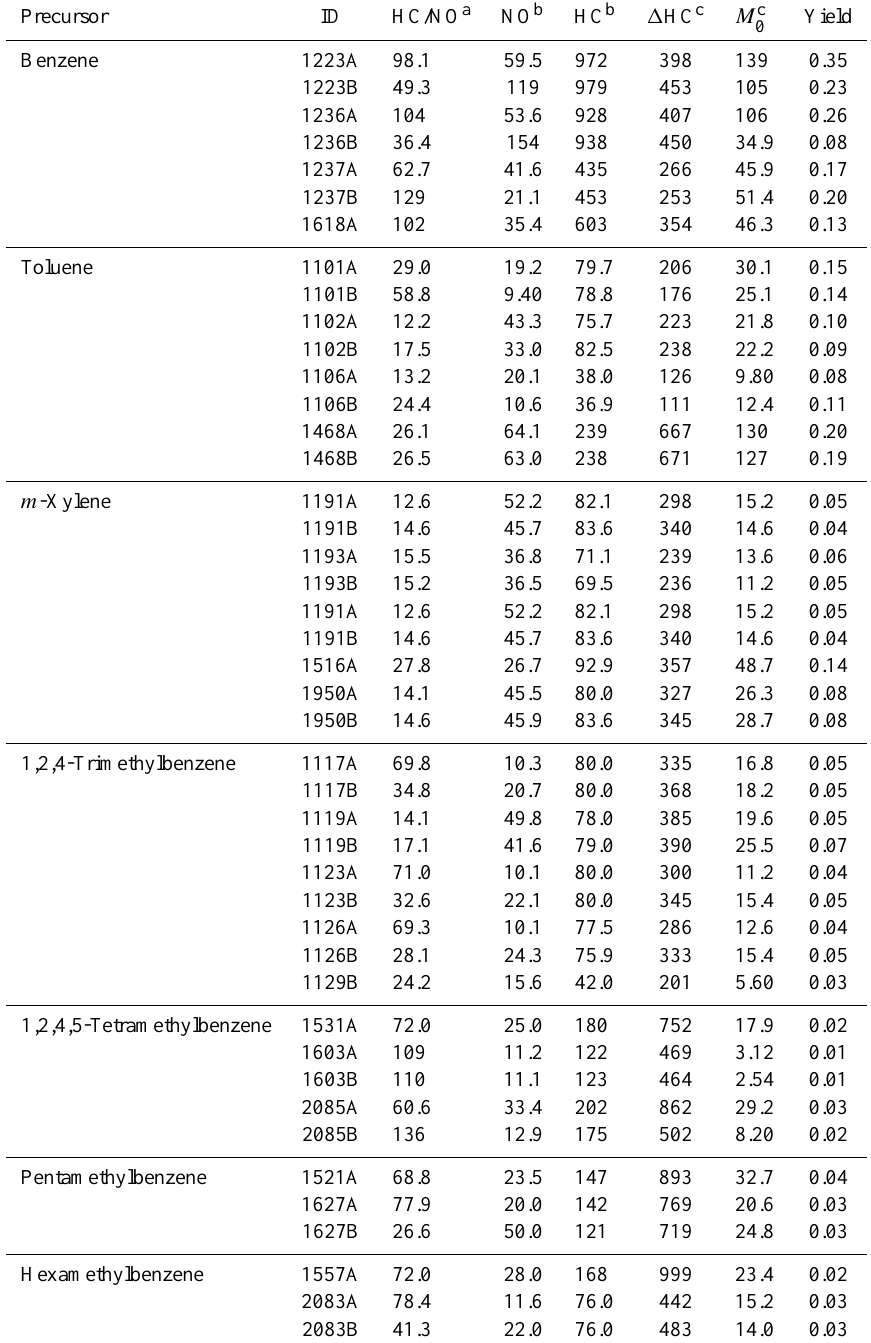
Table 1. Experiment conditions ∗